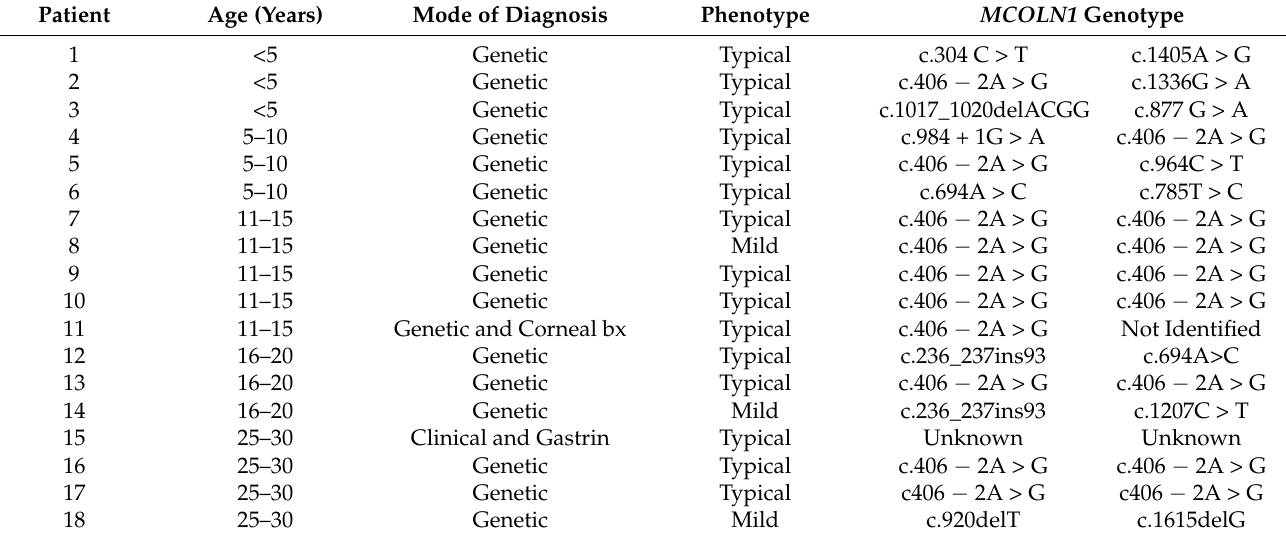
Table 1. Clinical and genotype data for study